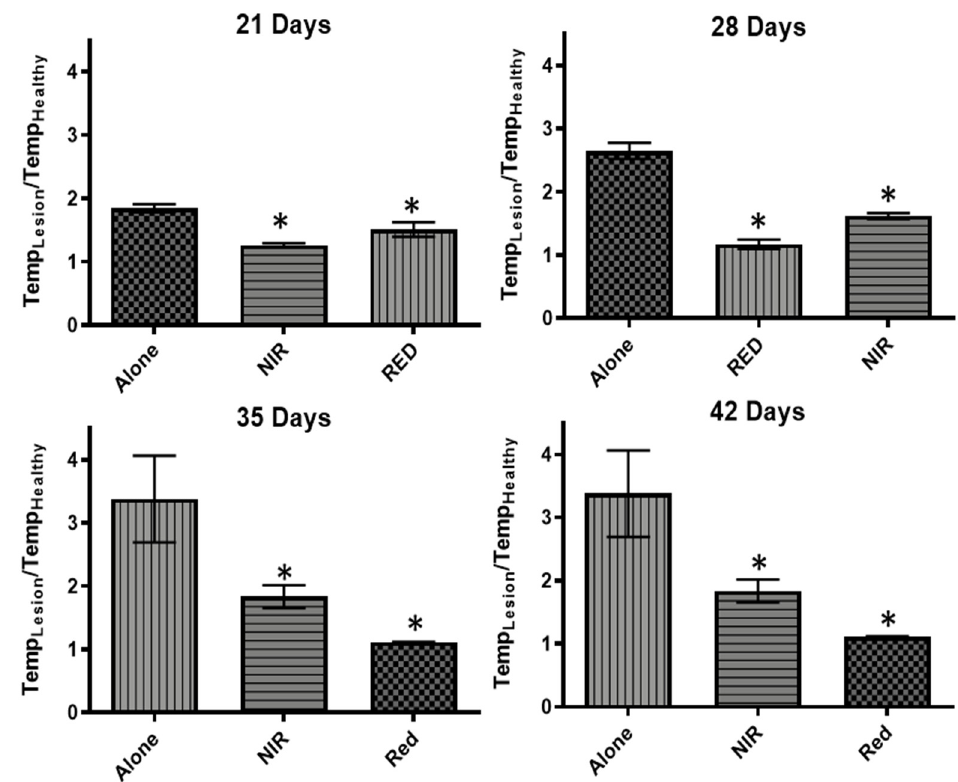
Figure 4. Thermal skin imaging to assess inflammation in radionecrosis lesion, compared with adjacent healthy skin in radiation and PBM-treated groups at 21, 28, 35, and 42 days. Data are presented as means with standard deviation; * denotes statistical significance n = 6, p < 0.05 with Kruskal–Wallis and Dunn’s test.